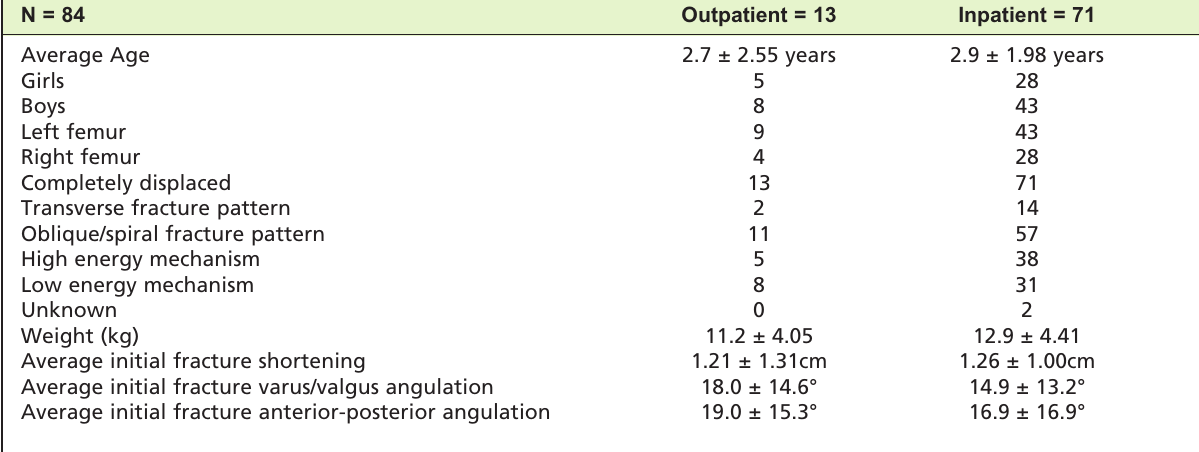
Baseline characteristics of inpatient and outpatient cohorts with displaced femoral shaft fractures Table I: N = 84